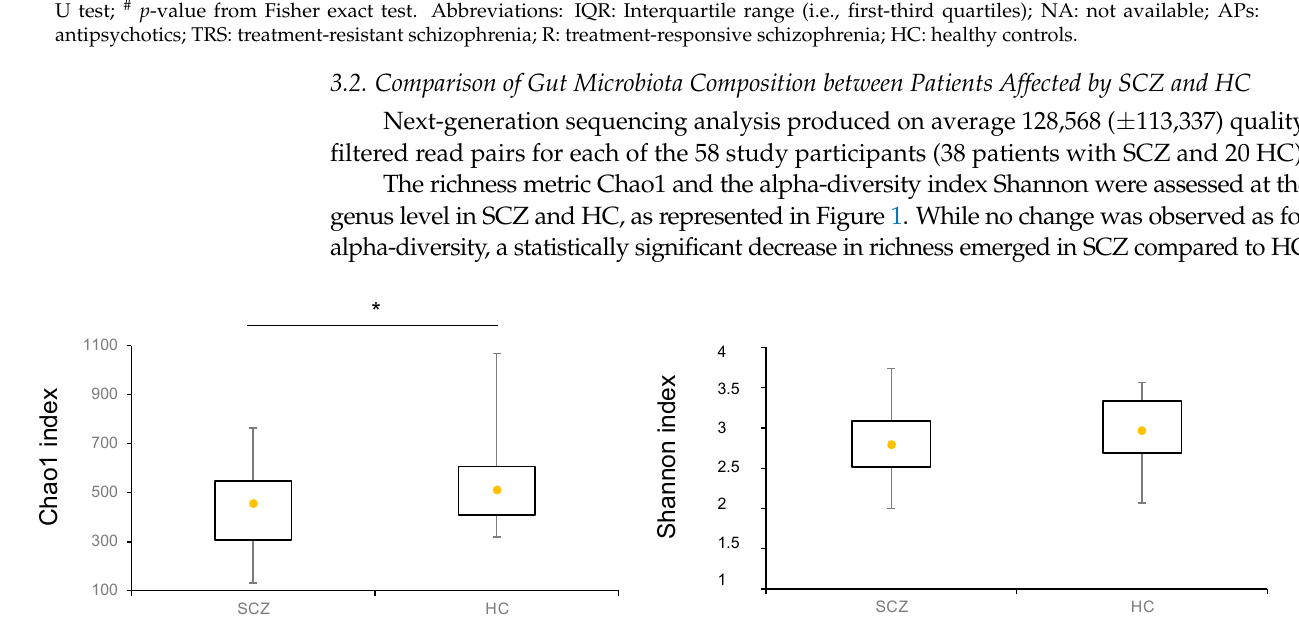
Figure 1. Boxplots of Chao1 index (richness) and Shannon index (alpha-diversity) calculated at the genus level in all patients affected by SCZ and HC. Yellow dot in each plot represents the median value. * p -value < 0.05.